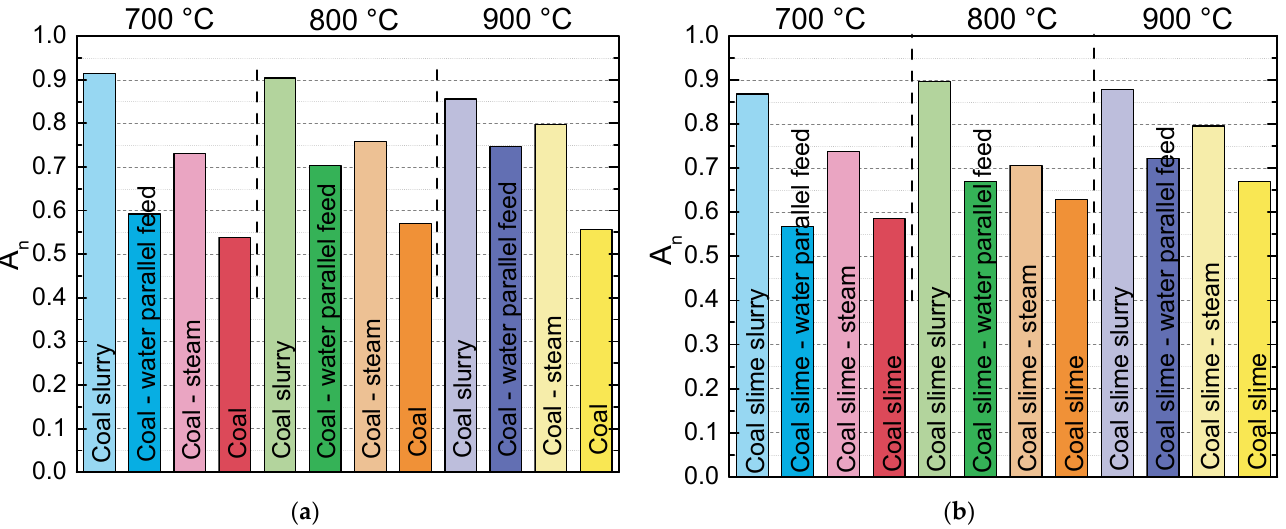
Figure 14. Efficiency indicators of fuels based on coal ( a ) and coal slime ( b ).